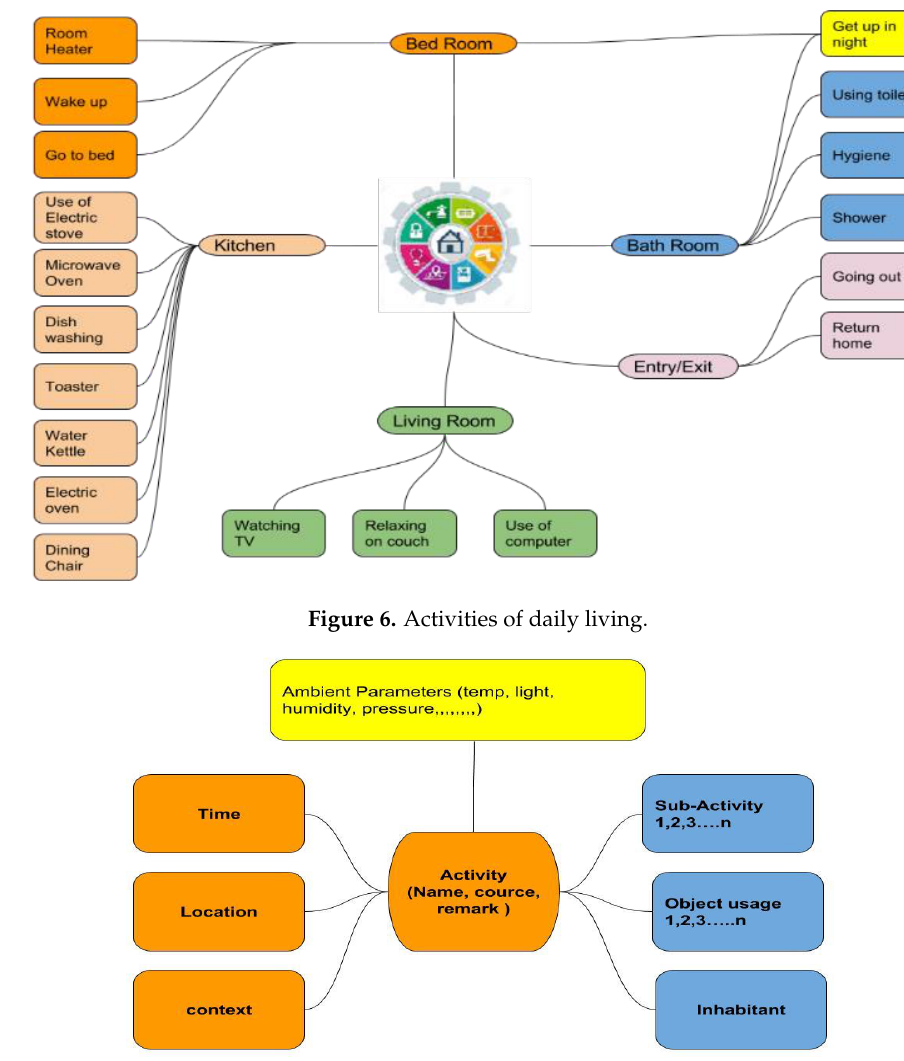
Figure 7. Modeling sub-activity for Activities of Daily Living. Table 1. Activity Annotation for 24 h.